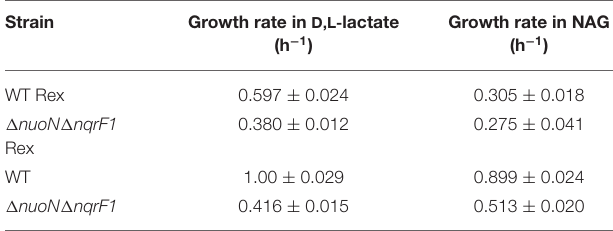
TABLE 3 | Comparison of growth rates of WT and 1 nuoN 1 nqrF1 with and without the Rex sensor growing in M5 supplemented with 0.1% tryptone and either 20 mM D,L -lactate or 10mM NAG from Figure 7 .